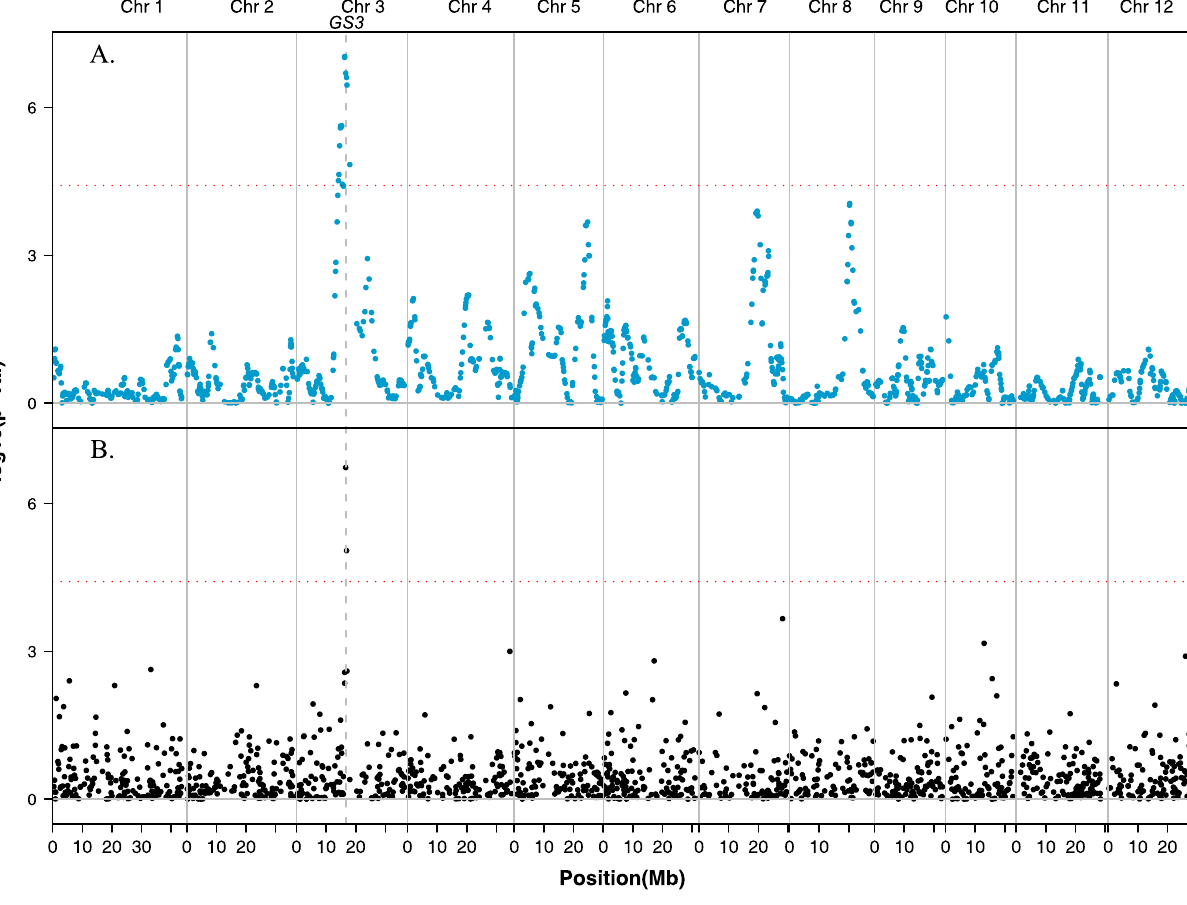
Figure 5. Admixture mapping and association mapping p-values for grain length. (A) Admixture mapping p-values for grain length using the tropical japonica component in the admixed subpopulation. (B) Association mapping p-values for grain length in all accessions using the subpopulation component matrix Q (K=5) as cofactors in the model. Horizontal dotted lines represent significance value of 0.05 after Bonferroni correction. Chromosomes are separated by vertical grey lines; GS3 gene on chromosome 3 shown as vertical dashed line.